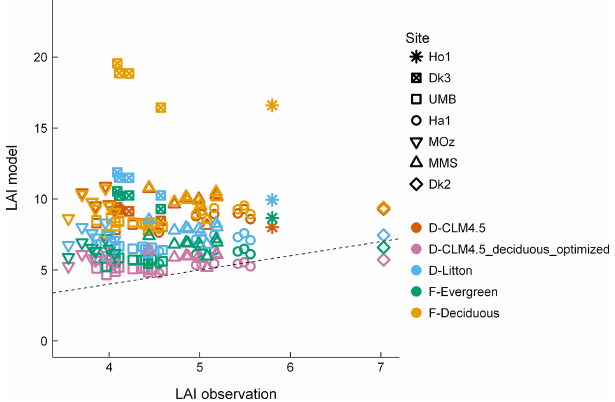
Figure 6. Comparisons between LAI measured in situ and LAI in the model for the different C allocation schemes (D- CLM4.5_deciduous_optimized refers to the one with the opti- mized leaf C–LAI relationship for deciduous forests in D-CLM4.5). Dashed line is 1 : 1 relationship between observations and model. Observations (LAI measured in situ) are from the AmeriFlux